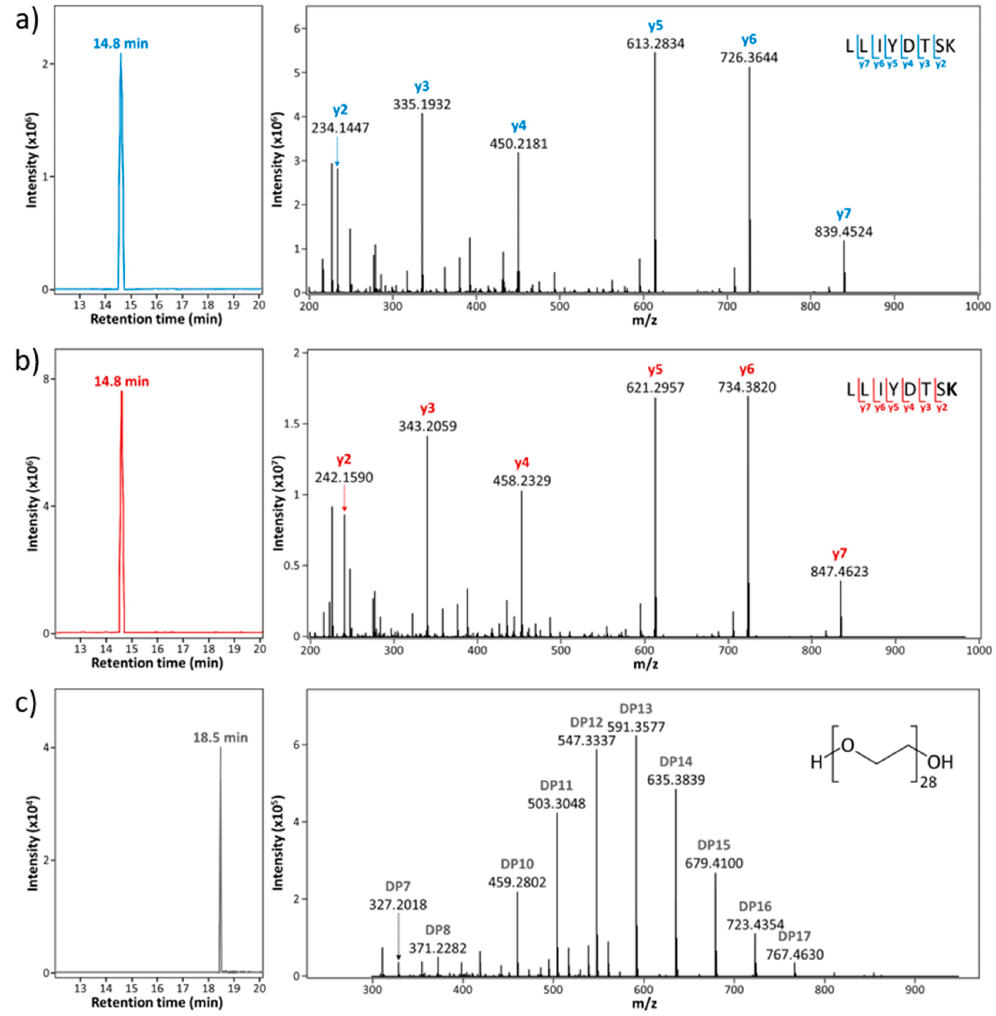
Figure 2. Extracted ion chromatograms (left) and tandem MS spectra (right) of the unique peptide of palivizumab, the SIS peptide and PEG-28 in the standard mixture: ( a ) the unique peptide at m / z 476.771 (z = 2, 14.8 min); ( b ) the SIS peptide at m / z 480.778 (z = 2, 14.8 min); and ( c ) PEG-28 at m / z 417.922 (z = 3, 18.5